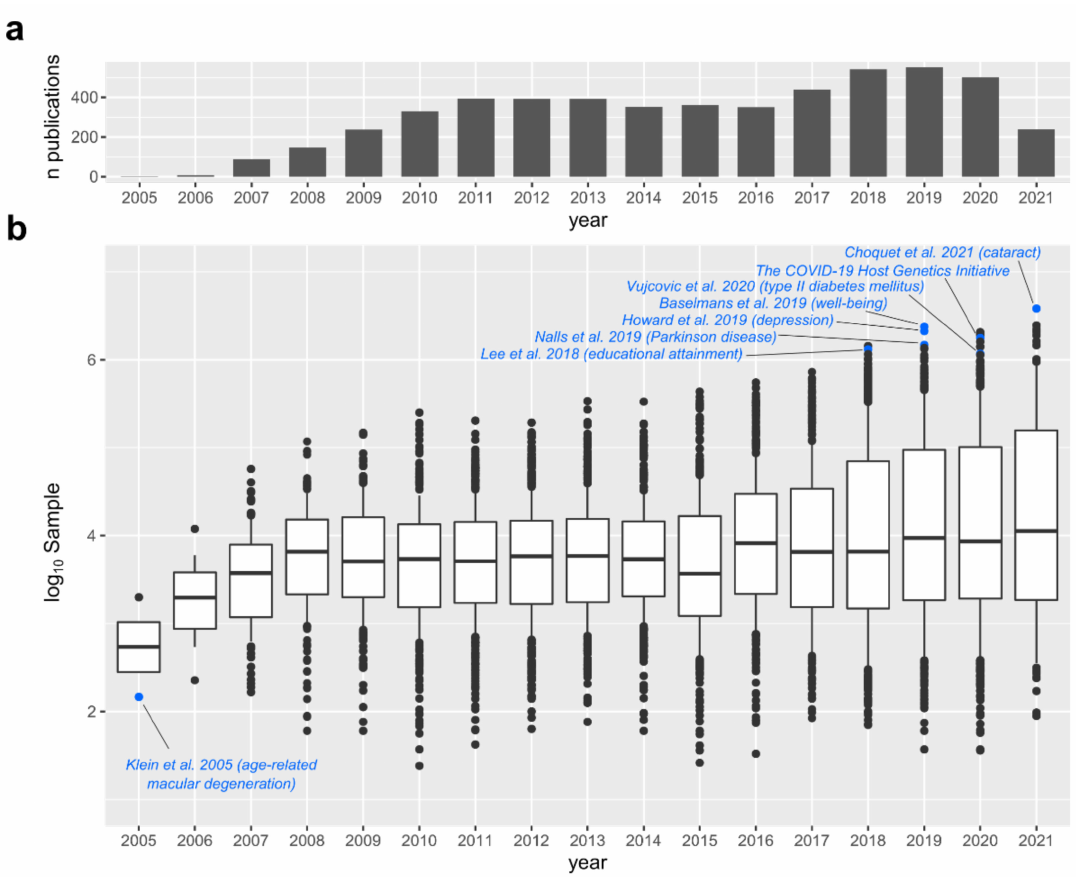
Figure 2. Published studies with available summary statistics that are included in the GWAS Catalog. ( a ) Number of studies added to the GWAS Catalog by year. ( b ) Sample sizes in the GWAS Catalog over time. Some studies mentioned in the text are highlighted. The data were accessed through the GWAS Catalog site on 21 September